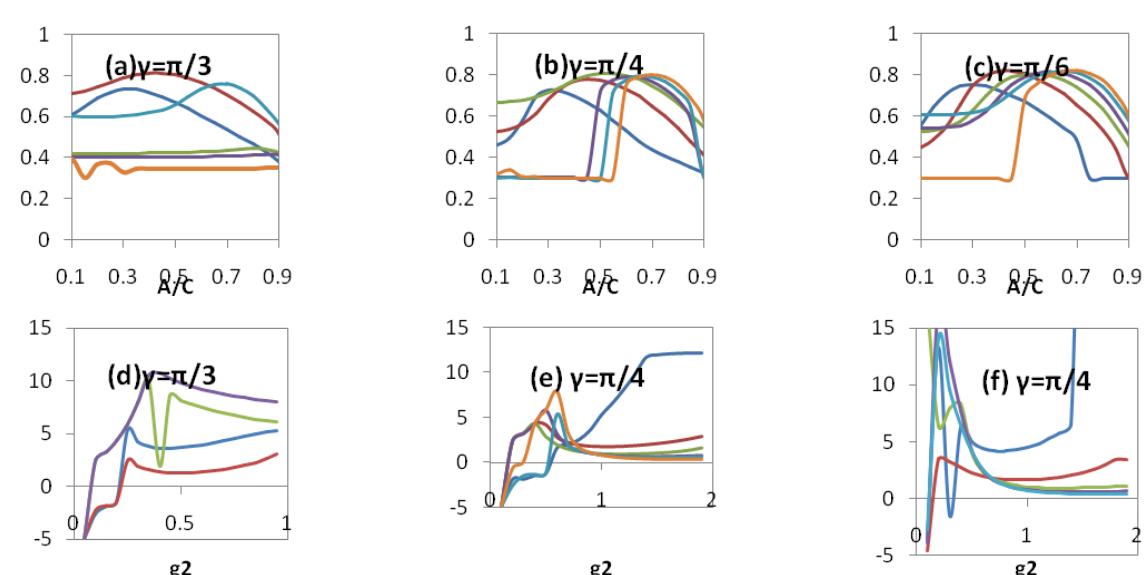
Figure A.2: Two-layer model with growth. Anisotropic layer modeled by full form of strain energy function. Critical buckling strain at the inner radius α plotted for various buckling mode. Enforced circular outer boundary condition. µ i =40kPa; µ o =8kPa; k 1 =1; k 2 =0.2. (a-c) α plotted against tube thickness A/C. (B-A)/(C-A)=0.2. g 1 =1.0, g 2 =1.0. (d-f) Critical buckling pressure P plotted against g 2 . A=1.0, B=1.1, C=1.5. g 1